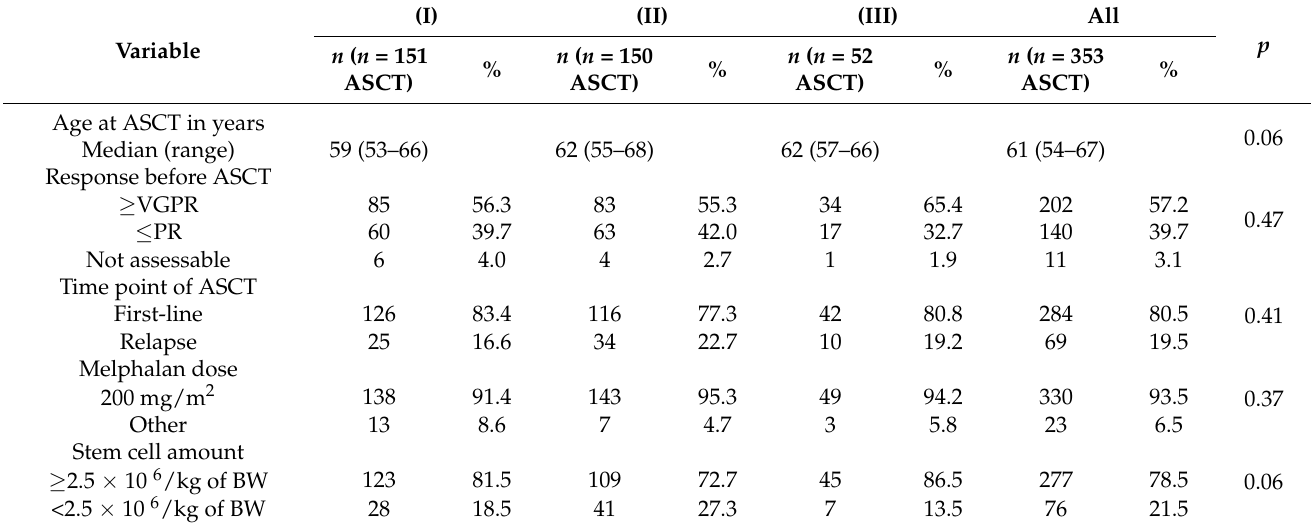
Table 2. Characteristics of ASCT in the three groups of anti-infective strategy: (I) antibiotic prophylaxis; (II) G-CSF support; and (III) no prophylaxis.